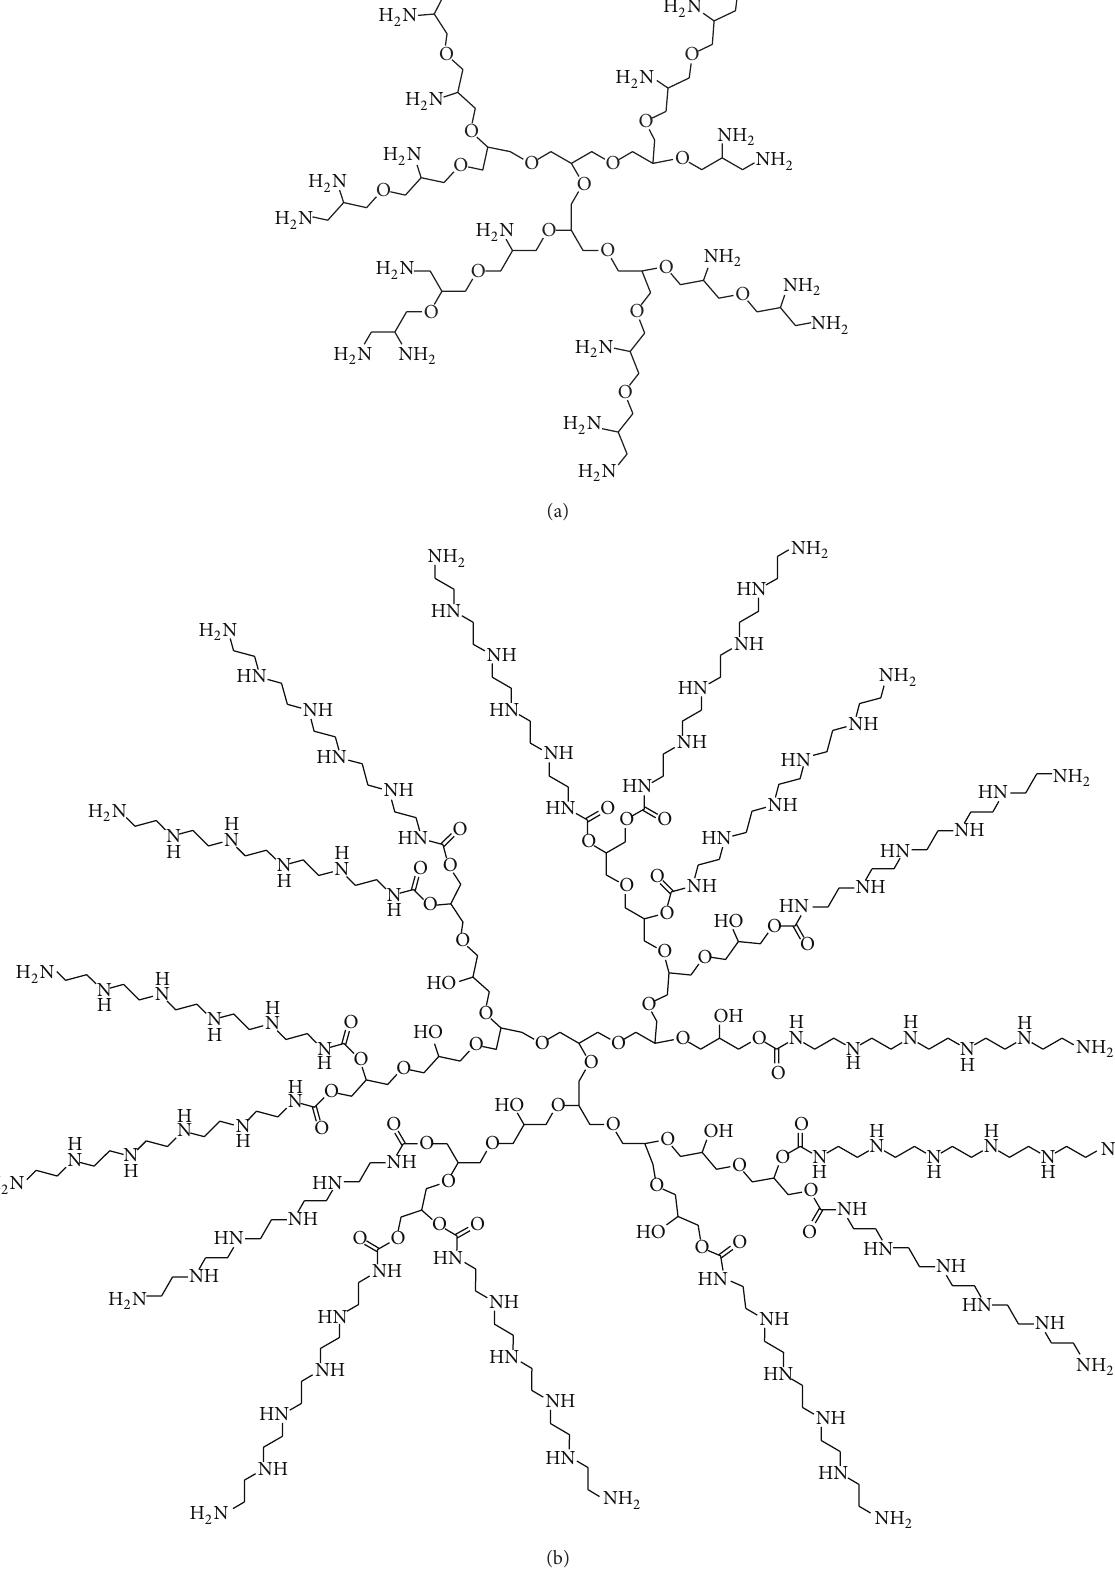
Figure 8: Polyglycerol derived dendrimers. (a) PG-NH 2 ; (b)